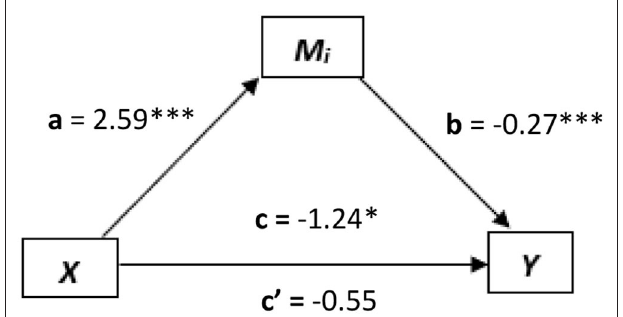
TABLE 4 | Model summary where alexithymia Total is DV.